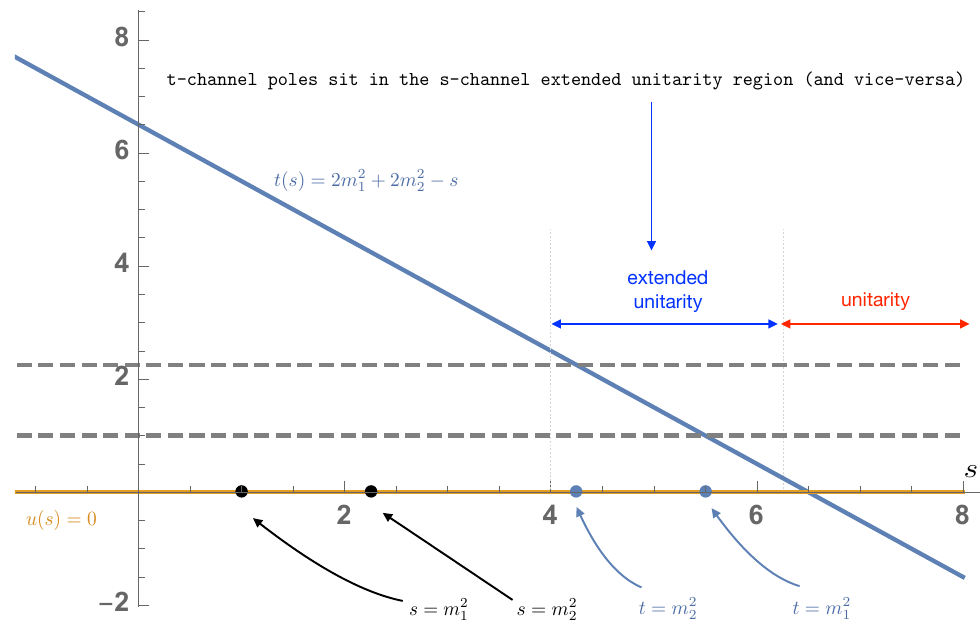
Figure 5 . t ( s ) (blue) and u ( s ) = 0 (yellow) for 12 → 12 forward scattering and m 2 = 3 s -channel extended unitarity sit t -channel poles (and vice-versa). The s -channel poles lie before the s-channel extended unitarity region. As in the previous figure, the grey horizontal dashed lines are equal to m 2 and m 2 determine the position of t -channel 1 2